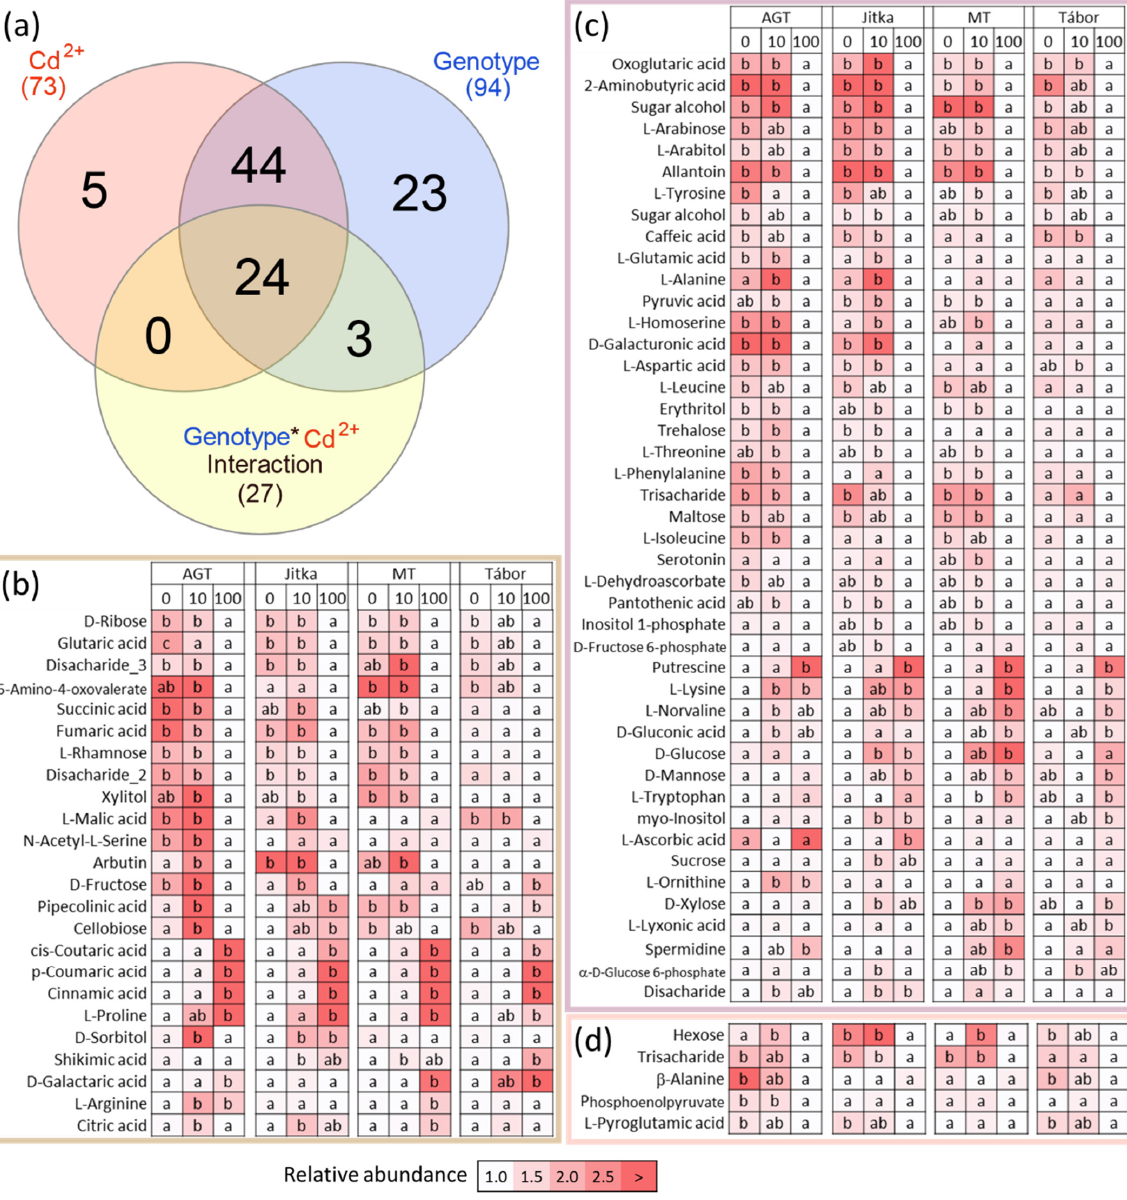
Figure 5. Metabolome analysis of flax root in response to cadmium. ( a ) Results of two-way ANOVA analysis visualized in a Venn diagram and the corresponding heat map visualization of subsets of ( b ) 24 metabolites whose abundances were affected by cadmium and genotype with significant interaction of these two factors, ( c ) 44 metabolites that showed genotype- and cadmium- specific responses and no interaction of these two factors, and ( d ) five metabolites that showed only a genotype-independent response to cadmium. Different letters indicate significant differences (Kruskal-Wallis and Dunn’s test, p < 0.05). For simplicity, the tests and normalization in the heat maps are limited to the genotype level. For cross-genotype comparisons, see the Supplementary Table S6.